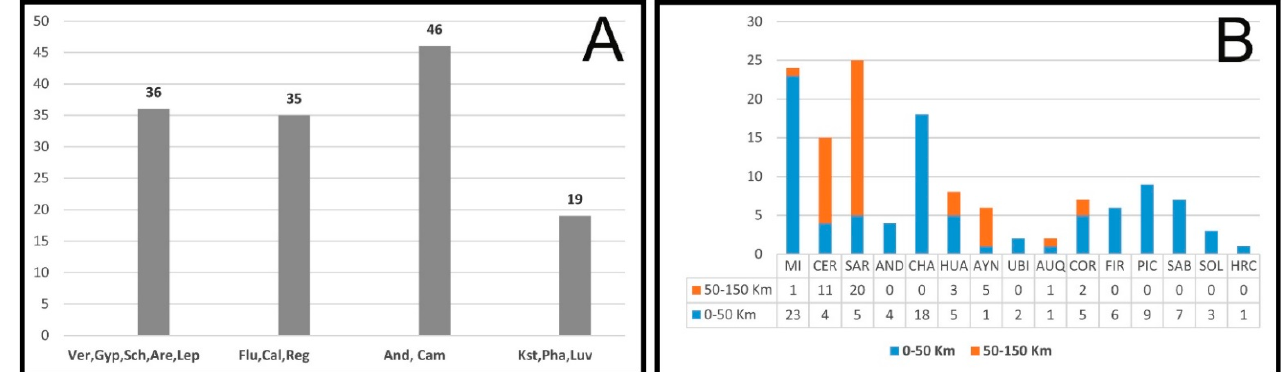
Figure 7. ( A ) Distribution of Asteraceae collections among the different soil groups according to the quadrants marked by the axes in Figure 3 (Ver: Vertisols, Gyp: Gypsisols, Sch: Solonchaks, Are: Arenosols, Lep: Leptosols, Flu: Fluvisols, Cal: Calcisols, Reg: Regosols, And: Andosols, Cam: Cam-